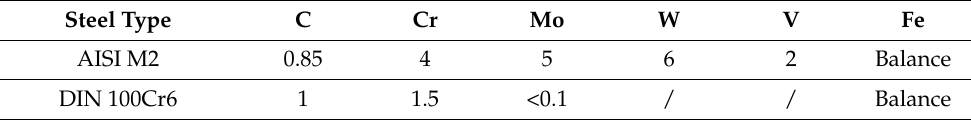
Table 1. Composition of the steel samples used (in weight